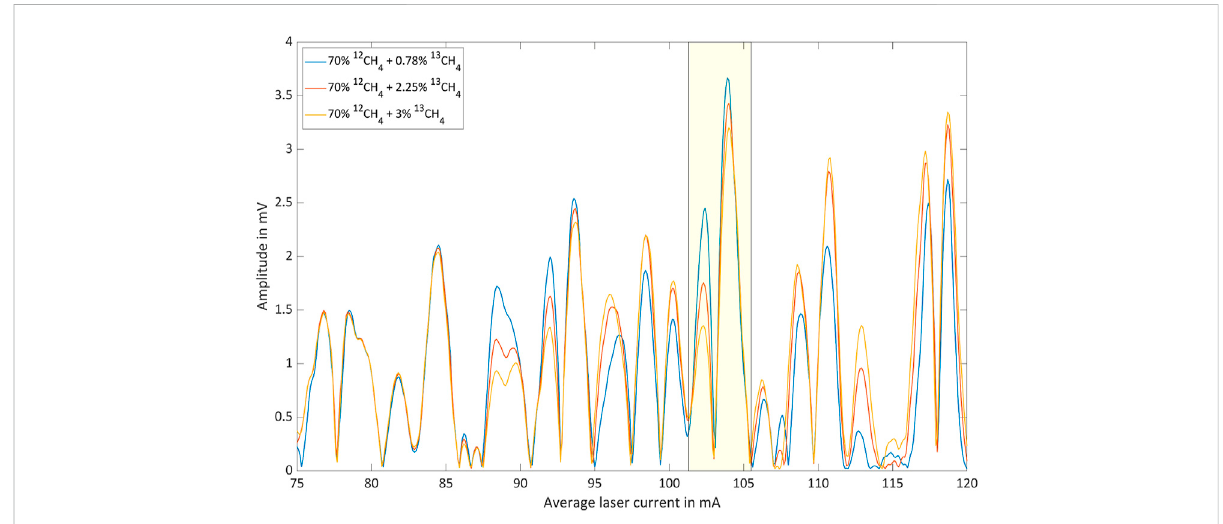
FIGURE 8 Photoacoustic signal as function of the average laser current for 70% 12 CH 4 with three different 13 CH 4 shares in nitrogen.